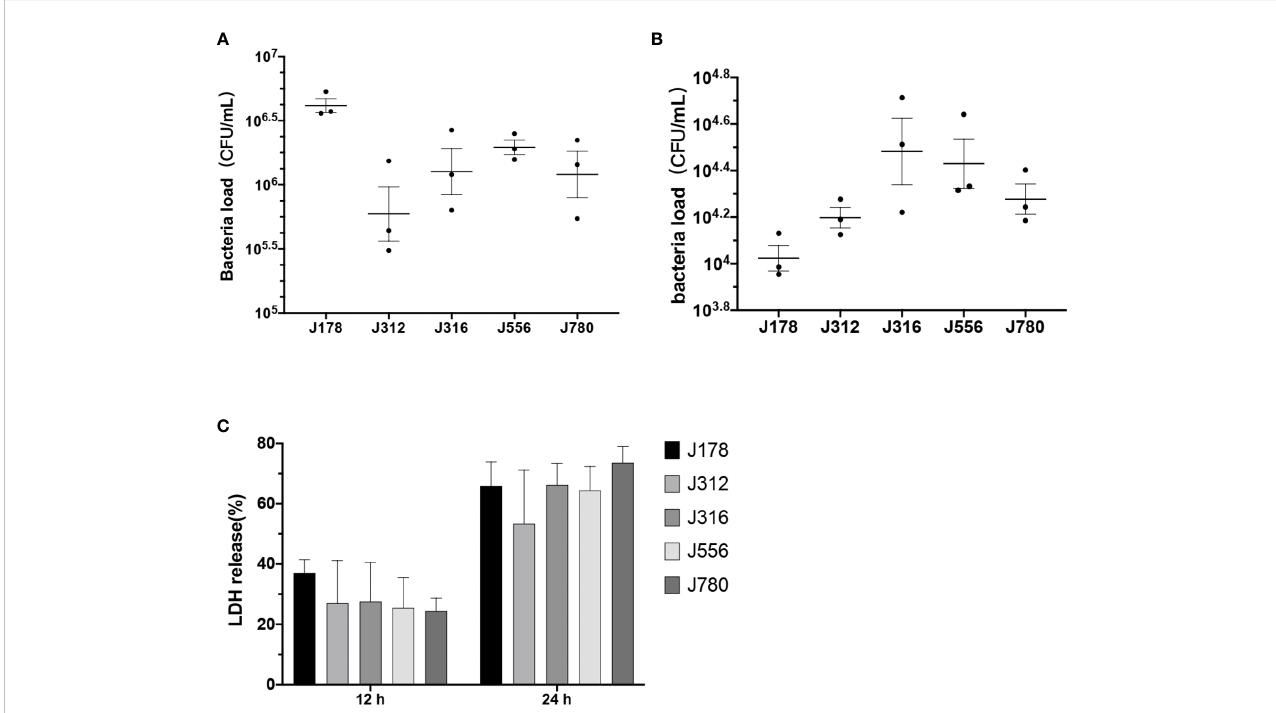
FIGURE 5 The adhesion, invasion, and cytotoxic ability of Erwinia sorbitola sp. nov. on RAW264.7 cells. (A) The number of bacterial loads adhered on cells; (B) the bacterial loads that invaded cells; (C) LDH released in the medium was used to assess the cytotoxicity of Erwinia sorbitola sp. nov. (Strains: J178, J312, J316, J556, and J780 T . Infection dose: MOI 100. Adherence time: two hours and two hours of antibiotic treatment to kill the exocellular bacteria. All the assays were repeated three times, and each experiment was performed in triplicate. Results were presented as Mean ±